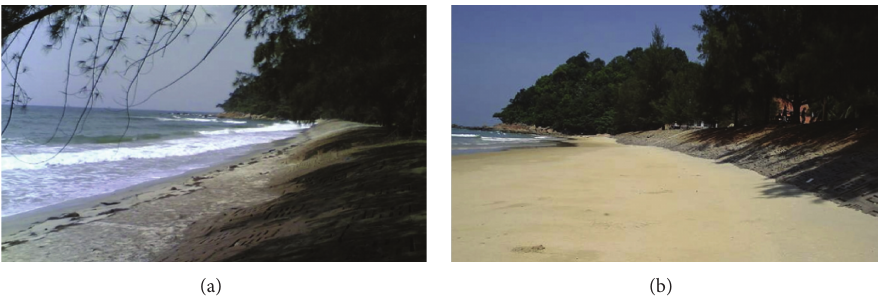
Figure 4: Condition of beach (a) before and (b) after the installation of geotextile tubes.